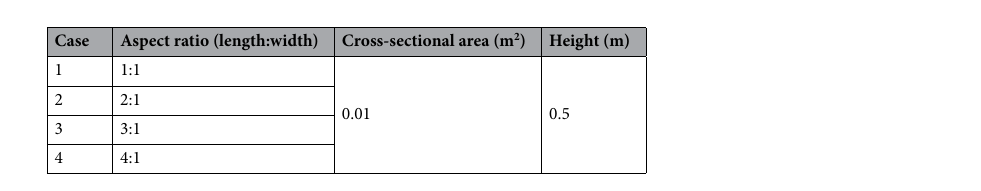
Table 2. Dimensions of the computational domain.